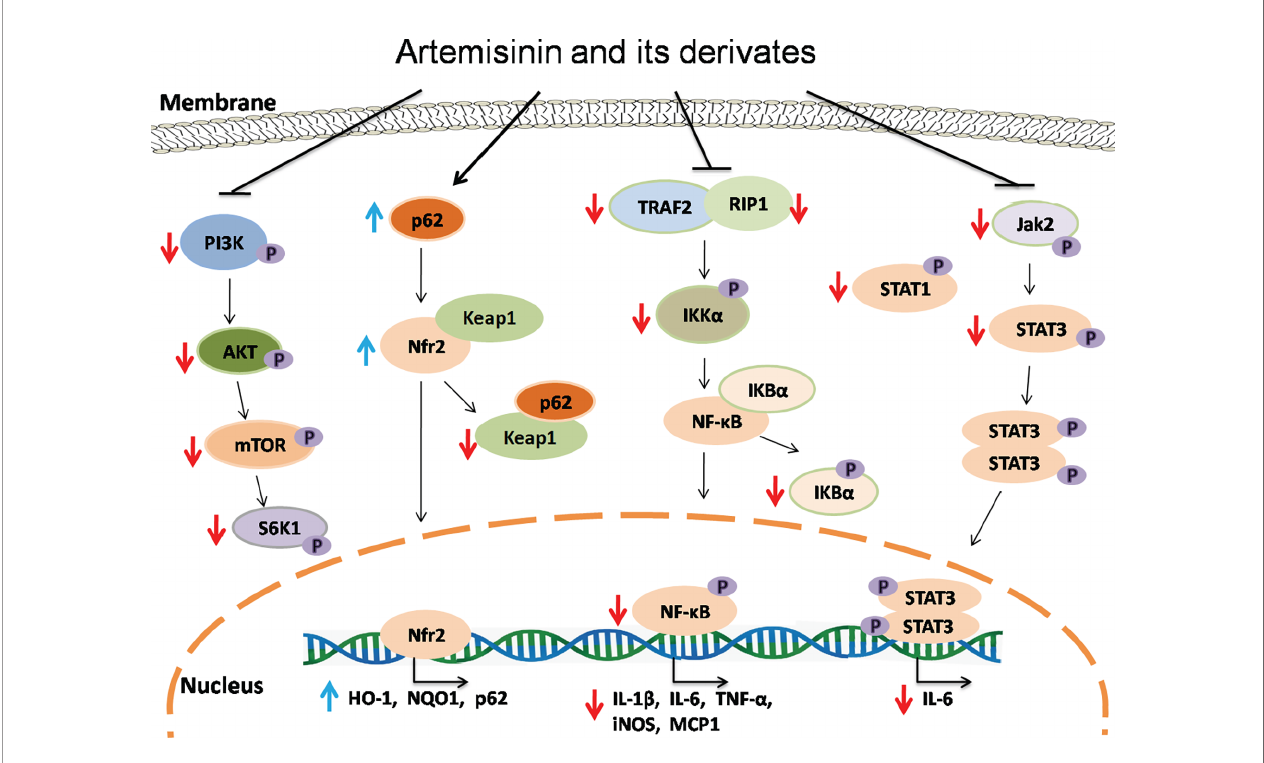
FIGURE 2 | The signaling mechanisms underlying effects of artemisinin and its derivatives. Artemisinin and its derivatives exert immunoregulatory and anti- in fl ammatory effects via interfering with NF-kB, Nrf2, Jak/STAT and mTOR signaling pathways, resulting in downregulation of proin fl ammatory genes and upregulation of anti-in fl ammatory and antioxidant genes. Red downward arrows indicate suppressive effects, while blue upward arrows denote stimulating